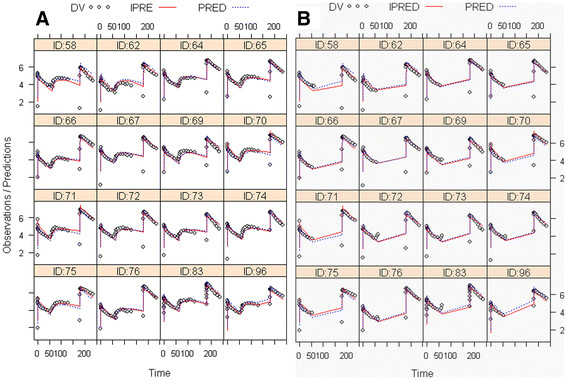
Modeling results of (R)-[11C]verapamil concentration-time curves in WB of rats in ln(Bq/ml) over time (min). (A) WB was compared with (B) WB* excluding the increase of (R)-[11C]verapamil brain uptake after treatment with tariquidar from 60 to 140 min. Tariquidar (3 or 15 mg/kg) was administered at 60 min after start of tracer injection as an I.V. bolus over 60 sec and the post-inhibition scan was started 2 h after tariquidar administration. Each panel represents one animal (not all 21 are shown), open gray circles represent measurements (DV), solid red lines represent the model predictions for individual rats (IPRE), and broken blue lines represent the population model predictions (PRED).